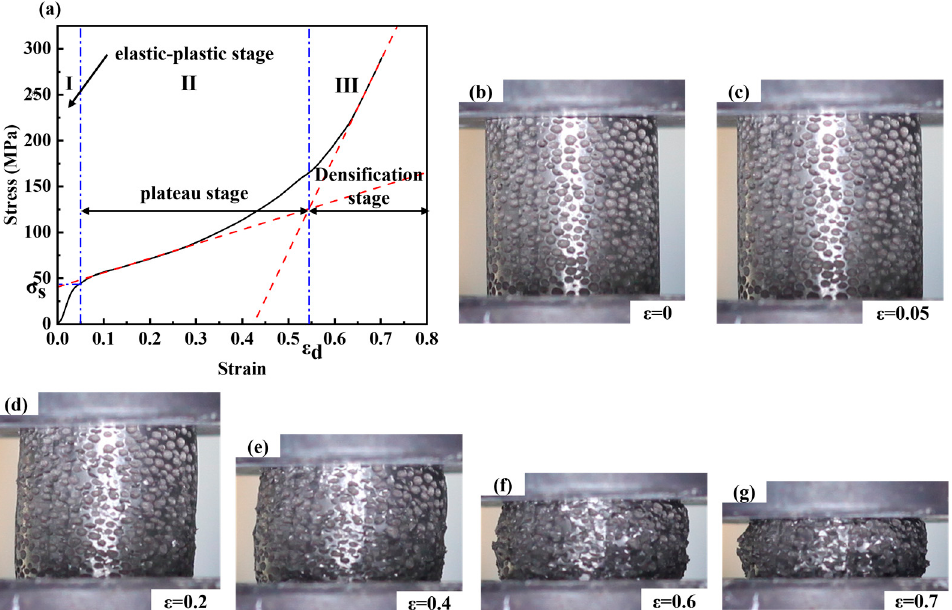
Figure 6. ( a ) Stress-Strain curve of the steel foam, and the section image with different deformation: